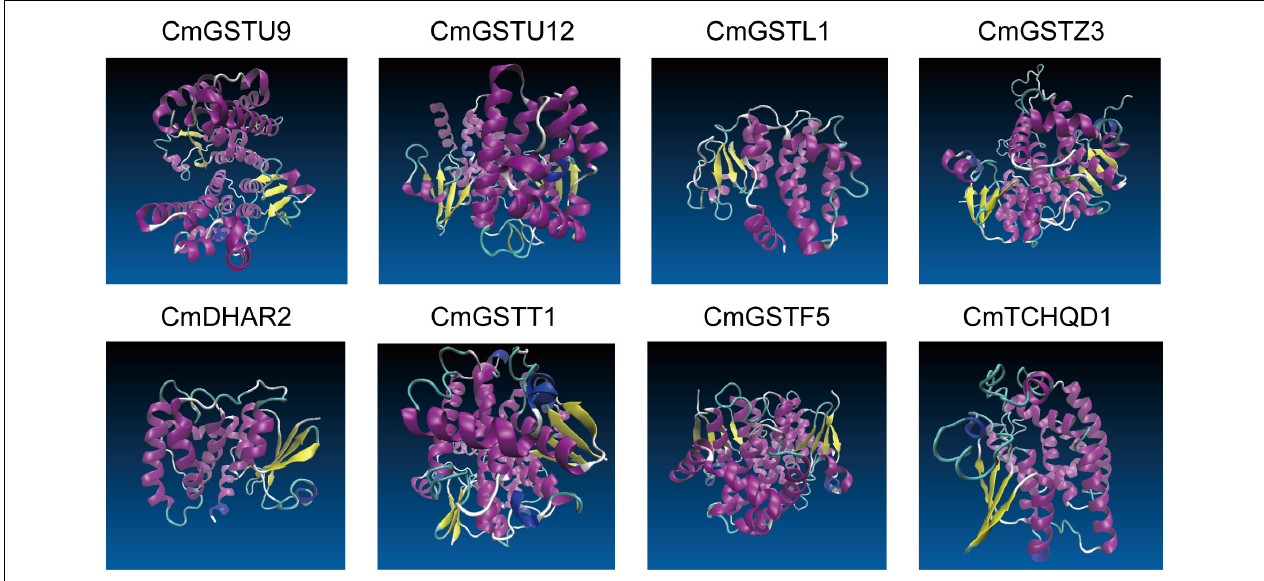
FIGURE 6 | The 3-D models of eight CmGST proteins. Different colors show the types of structures: α helices in purple, β sheets in yellow, turn in cyan, and random coil in white.